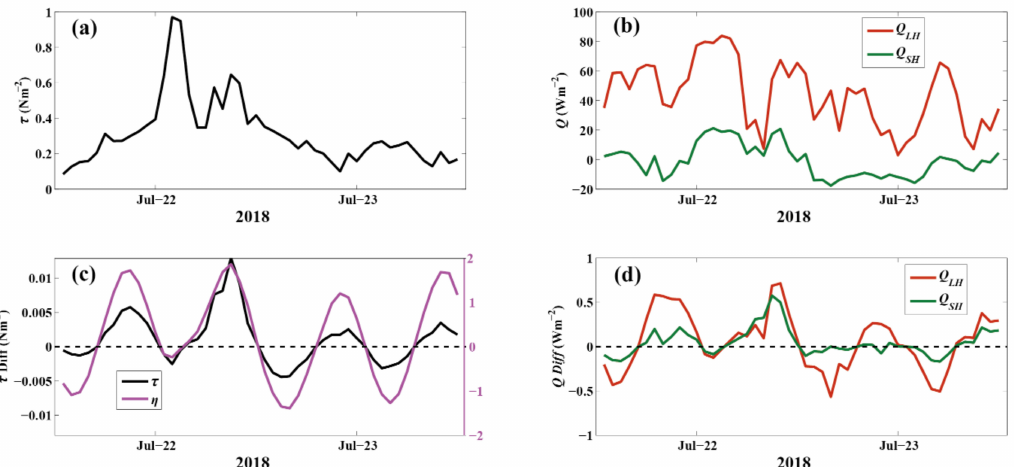
Figure 15. The wind stress (Nm − 2 , ( a )) and turbulent heat fluxes (Wm − 2 , ( b )) during TC Ampil from 22 to 23 July 2018. ( c ): Wind stress differences (left y-axis) with variations in the magnitude of SSE (magenta, right y-axis) during TC Ampil. ( d ) is the same as ( c ) but for Q LH (red, unit: Wm − 2 ) and Q SH (green, unit: Wm − 2